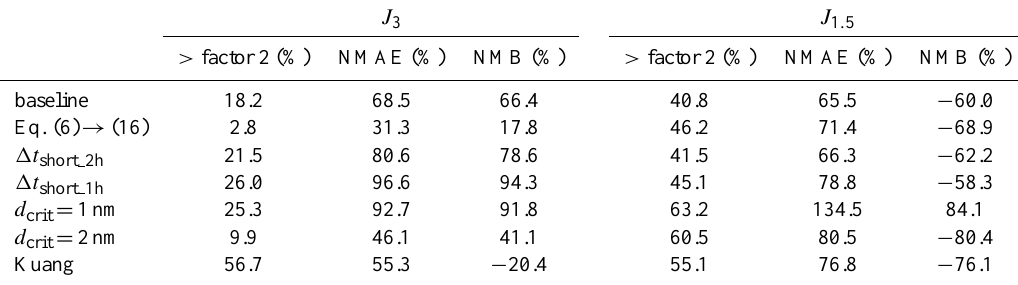
Table 2. Performance metrics for the different analysis set-ups when estimating the mean new particle formation ( J 3 ) and actual nucleation rates ( J nuc ) . The columns show the percentage of analysed events for which the estimate is not within a factor of two of the simulated rate ( > factor 2), the normalised mean absolute error (NMAE) and the normalised mean bias (NMB). Note that in sensitivity set-ups d crit = 1 nm and d crit = 2 nm the analysis tool calculates J 1 and J 2 , respectively, and these values are compared to the simulated J 1 . 5